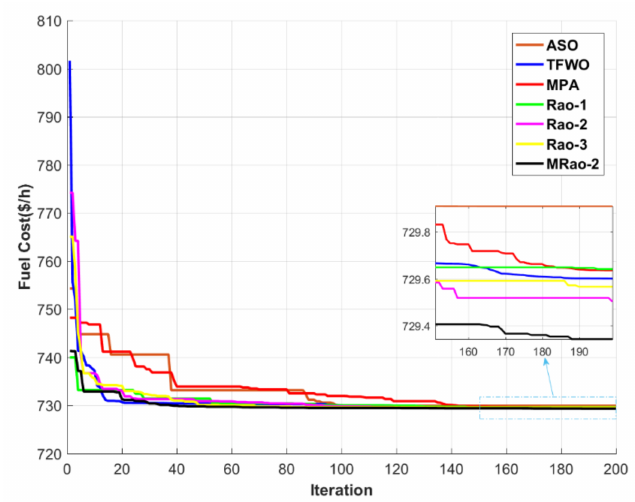
Figure 8. Convergence characteristics curves of all algorithms for case